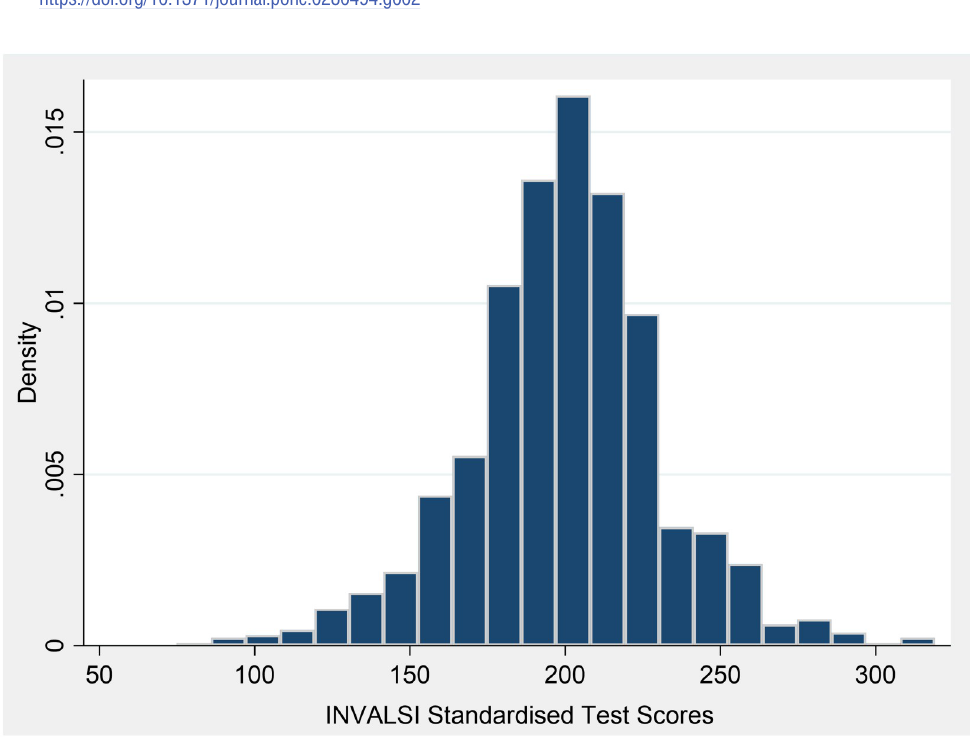
Fig 3. Histogram—INVALSI 2021 standardised test scores. Standardised test scores aggregated at teacher level, jointly considering Mathematics, Reding and English. Source: Authors’ elaboration using INVALSI 2021.